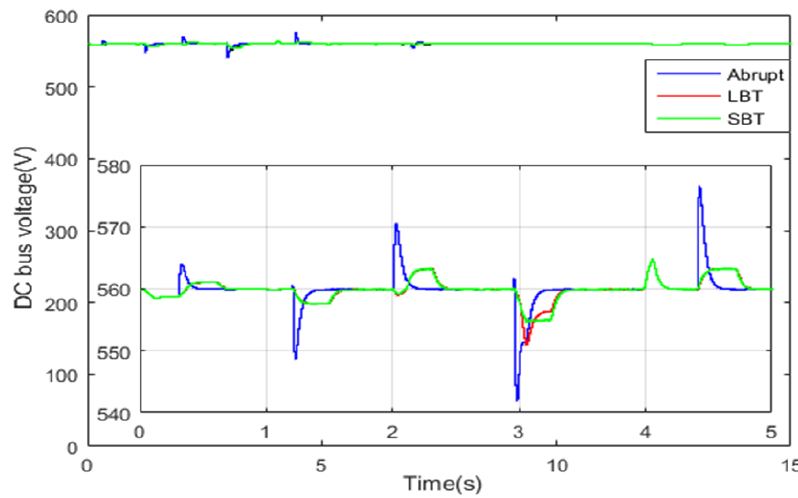
Figure 29. DC bus voltage.